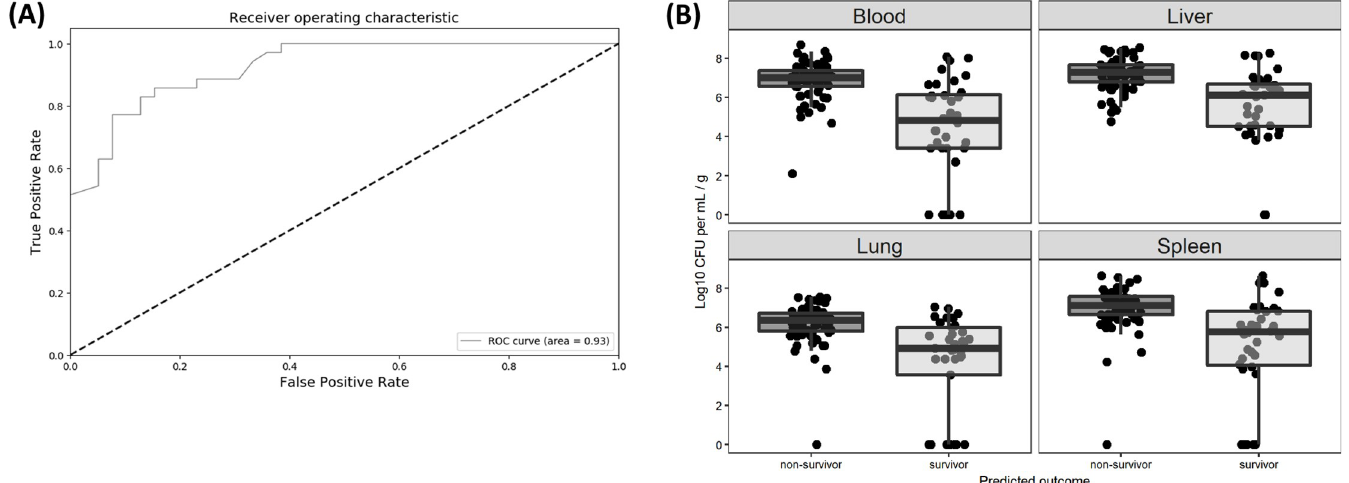
Fig 4. Survival or non-survival of neonatal mice was predicted at 24 HPC and was strongly associated with bacterial load. (A) Receiver Operating Characteristic curve illustrating the sensitivity and specificity of a Gradient Boosting Machine model trained on 148 mice and tested here on 74 mice. The model was primarily driven by weight change, righting reflex and mobility at 18 and 24 HPC. (B) Neonatal mice injected IP with cecal slurry were sacrificed 24 hours post challenge, with tissue and blood samples plated on sheep’s blood agar at time of sacrifice. Mice were predicted to survive or not survive based on righting reflex, mobility, and other biometric data. Mice which were predicted to survive had a significantly lower bacterial load in all measured biological compartments than predicted non-survivors (two-sided Wilcoxon rank-sum tests with Bonferroni correction, p < 0.001). All mice with zero bacterial load in the whole-blood (n = 9) were predicted to survive.